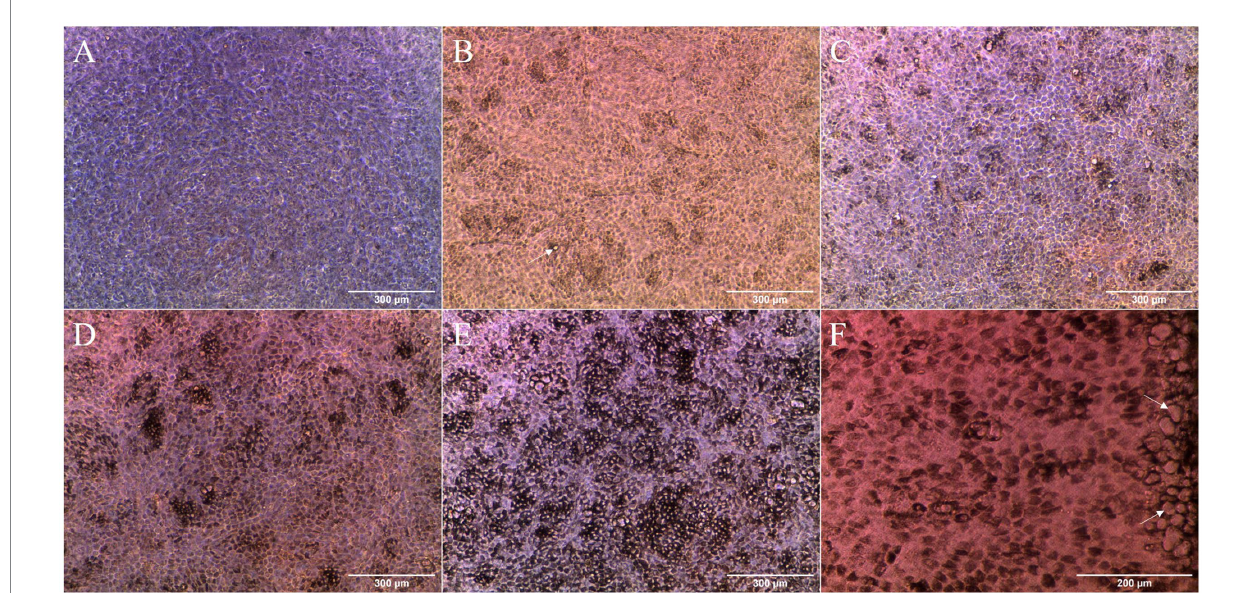
FIGURE 1 Optical microscopy images of the cell cultures at different time points: (A) 3 days; (B) 14 days; (C) 20 days; (D) 28 days; and (E) 38 days. Pigmentation of cells started at around 14 days in culture (B) and increased with time (C–E) . Possible extracellular deposits (arrows) could be seen starting at 14 days in culture ( B , white arrow). After 38 days in culture, extensive pigmentation could be found throughout the cell monolayer (E) . High concentration of possible extracellular deposits (arrows) was detected in the insert borders at 34 days (F)